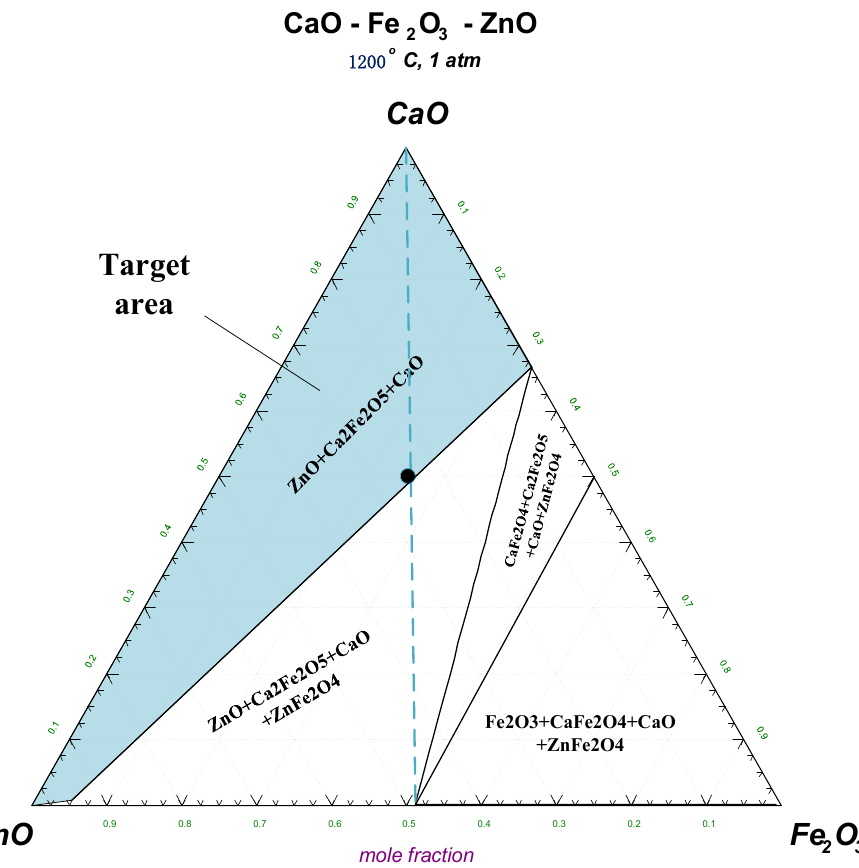
Figure 3. Isothermal section diagram of CaO-ZnO-Fe 2 O 3 at 1200 °C.